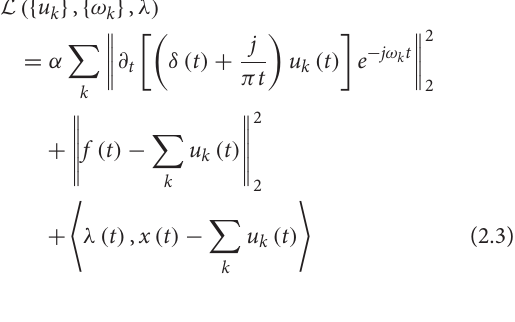
FIGURE 2 | Analysis of the value of K : the frequency-amplitude in double logarithmic coordinates of heart sound of a 1-year-old healthy boy collected in a quiet environment.